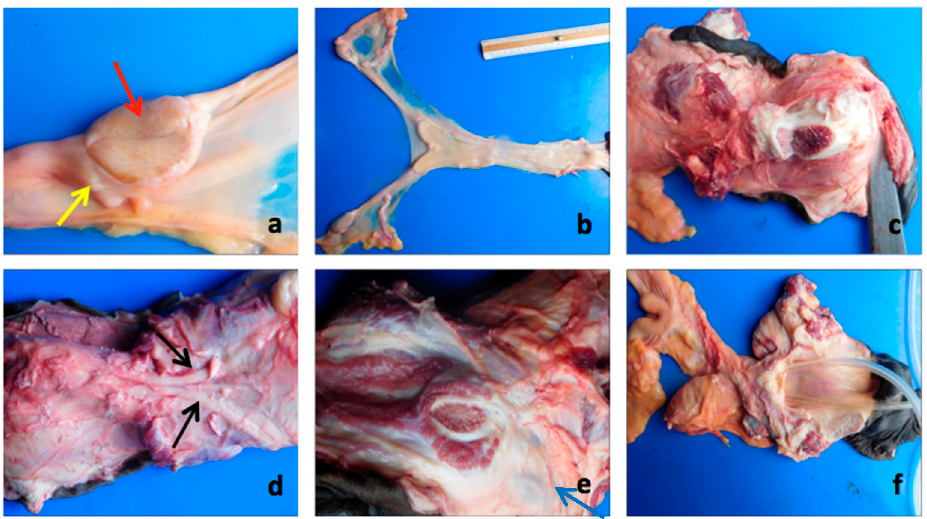
Figure 6. Anatomopathological examination. ( a ) Section of gonad (appearance to testicular parenchyma (red arrow → )), absence of the mediastinum and ausent follicular structure. Tubular-like structure in cranial area partially circumscribed the gonad (yellow arrow → ). ( b ) Uterine horns (6 cm) and uterine body (15 cm) and cervix (3 cm). In the longitudinal section, the longitudinal folds of the endometrium are visible. ( c ) Typical structures of the corpora cavernosa. ( d ) Retractor muscles of the penis (black arrows). ( e ) Ischiocavernous muscle and bulbourethral glands (2 cm; blue arrow → ). ( f ) The opening performed on fused vulvar lips led directly to the dilated pelvic urethra, helping us to locate the vaginal ostium of the